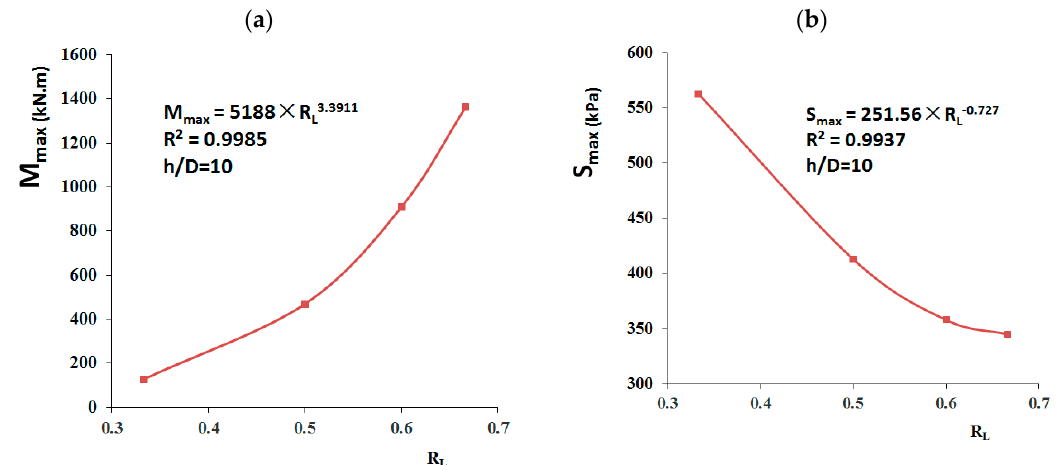
Figure 9. Relationship between the maximum internal force for a varying pile length and the sliding depth ratio to diameter ratio: ( a ) the relationship between the maximum bending moment and the sliding depth ratio; and ( b ) relationship between the maximum soil reaction force and the sliding depth ratio.